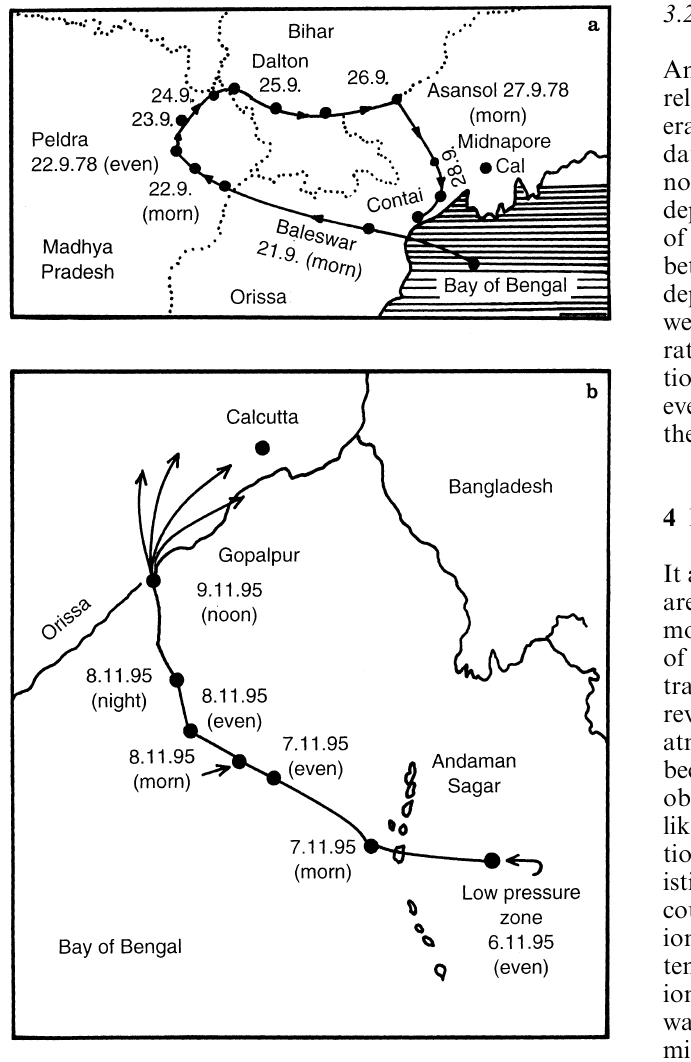
Fig. 8a, b. Schematic diagram showing the origin and track of a the monsoon depression during 21–28 September 1978 and b that of